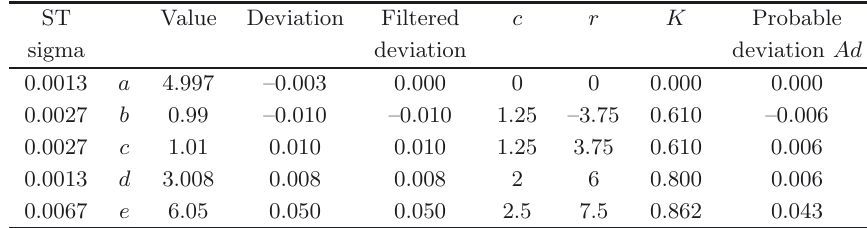
Table 11. Proposed corrections.